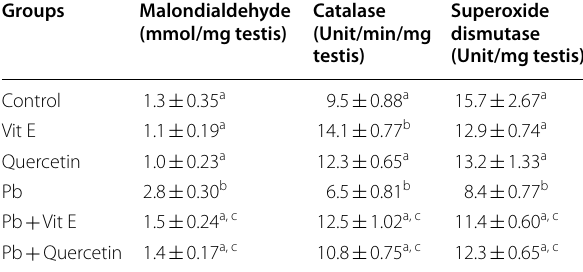
Means bearing different superscripts between groups differ significantly at p < 0.05